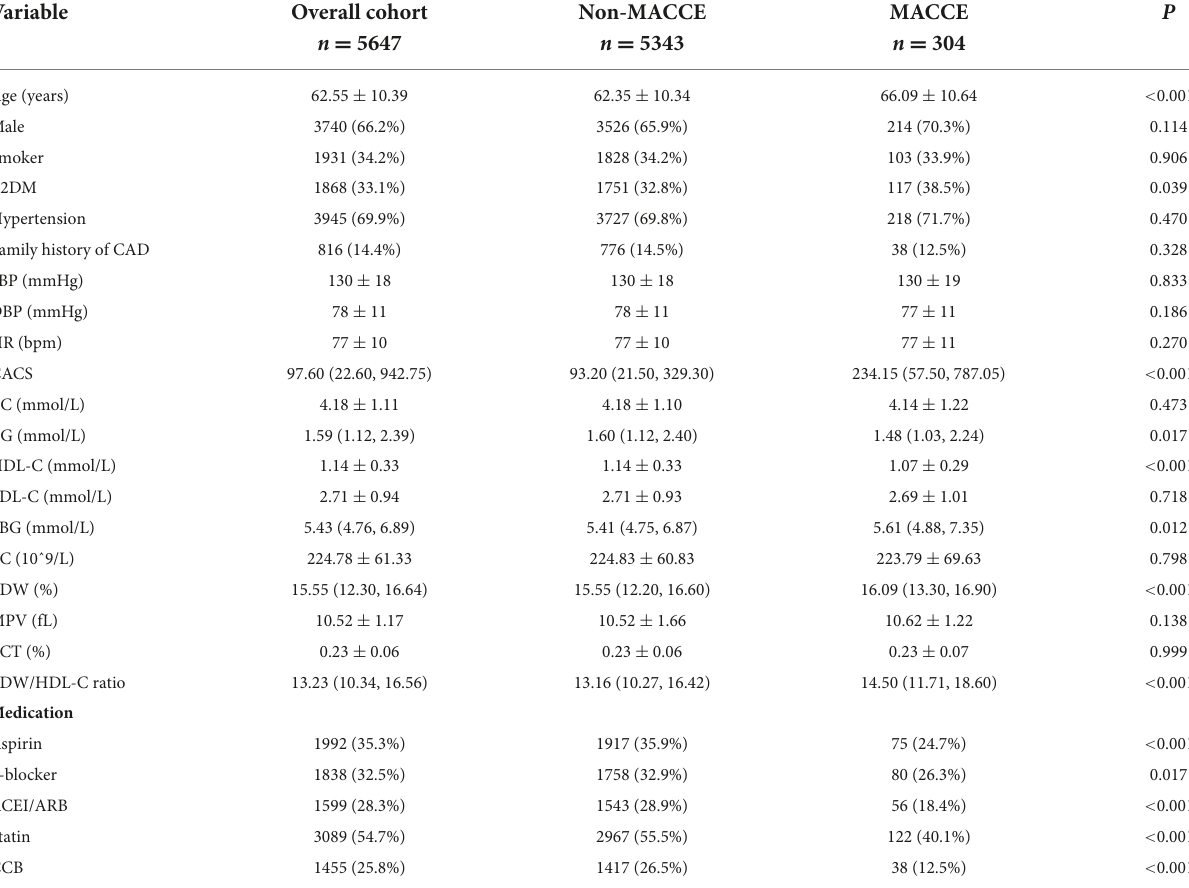
TABLE 1 Comparison of baseline characteristics between MACCE and Non-MACCE groups.